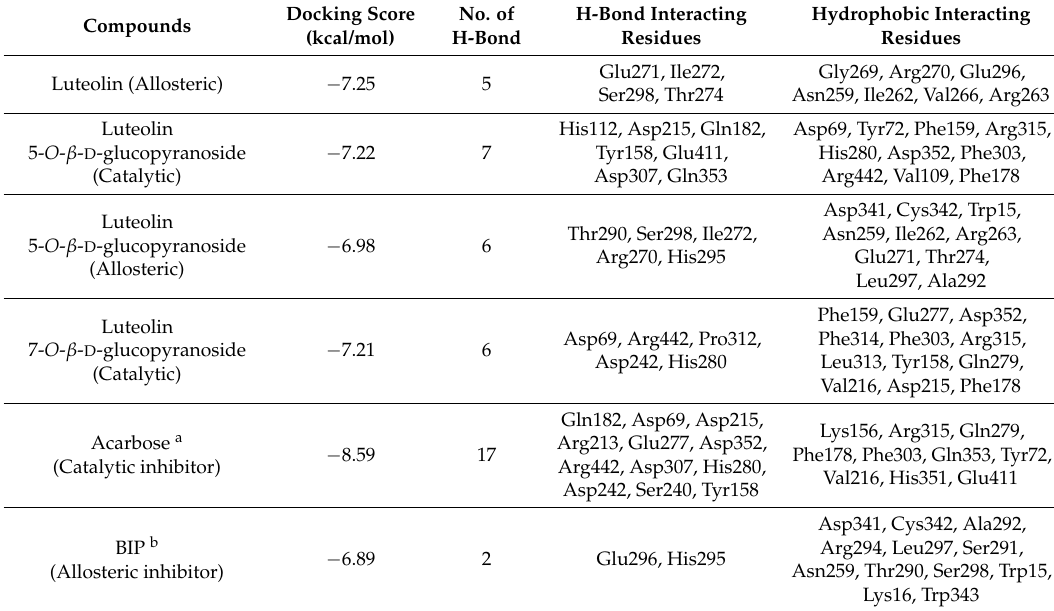
Table 4. Molecular interactions of the α -glucosidase (3A4A) active site with luteolin, luteolin 5- O - β - D -glucopyranoside and luteolin 7- O - β - D -glucopyranoside as well as reported inhibitors. Compounds